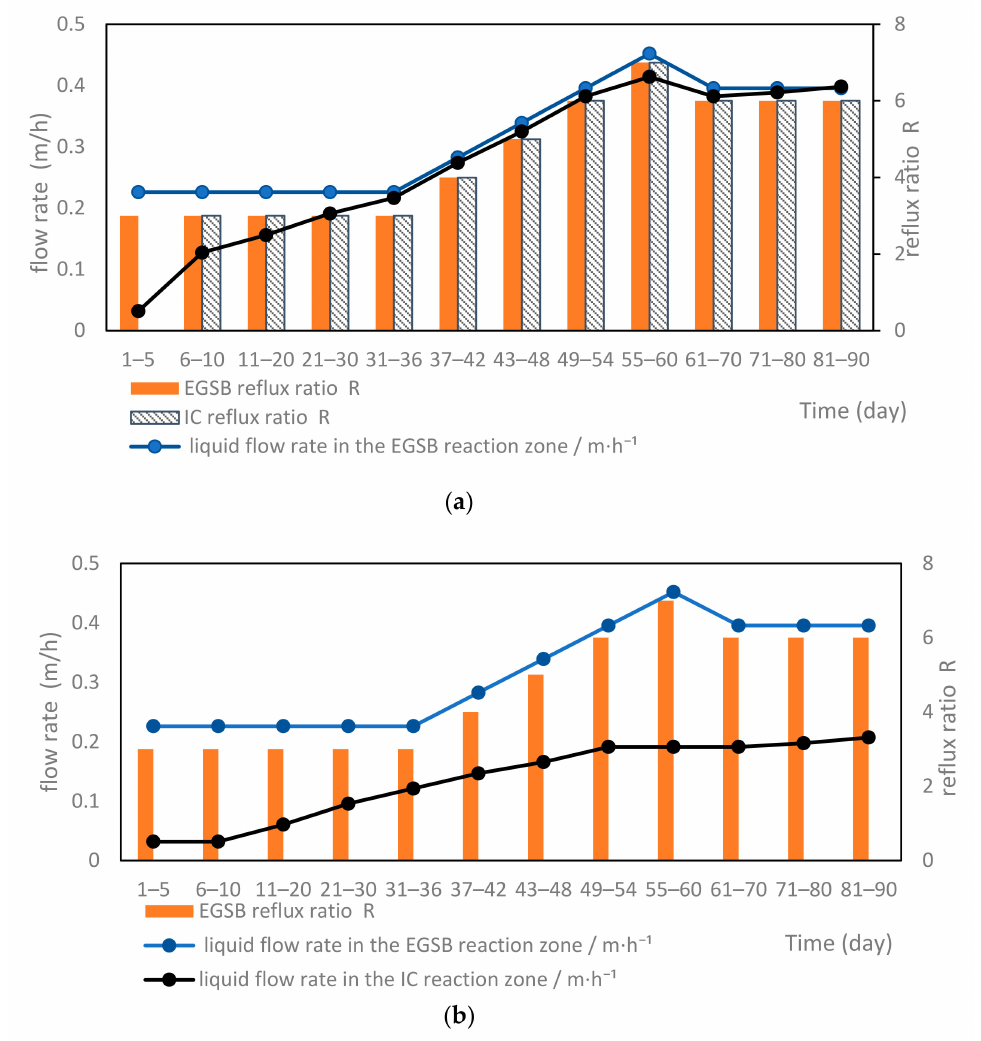
Figure 12. Relationship between the reflux ratio and the rising liquid flow rate. ( a ) IC reactor with external circulation. ( b ) IC reactor without external